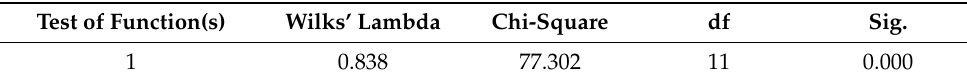
Table 7. Wilk’s Lambda analysis